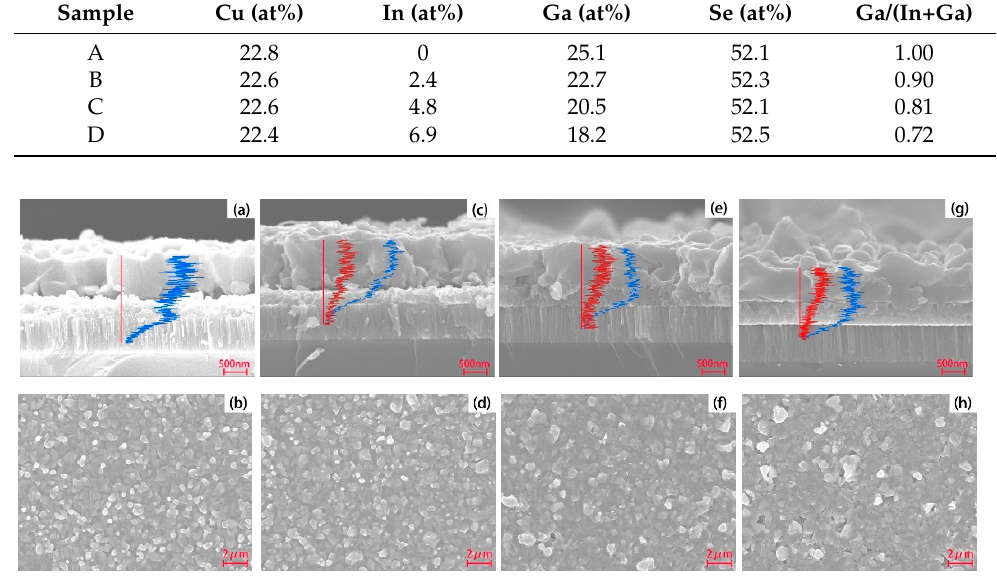
Figure 1. Cross-sectional and surface SEM images: ( a , b ) for GGI = 1.00; ( c , d ) for GGI = 0.90; ( e , f ) for GGI = 0.81; ( g , h ) for GGI = 0.72. The red line is for the distribution of indium along the depth of the CIGS fi lm, the blue line is for the distribution of selenium along the depth of the CIGS fi lm.